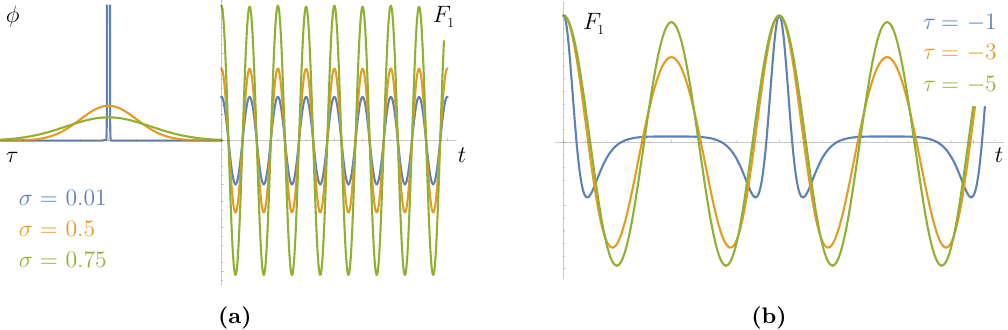
Figure 4. F 1 ( t ) for localized sources. (a) Gaussian sources on the Euclidean section with varying widths σ for a sample value of τ . The limit σ → 0 for which the source becomes a Dirac delta gives a finite response. Although drawn horizontally, the negative horizontal axis corresponds to imaginary time τ . (b) Sample responses for Dirac delta sources at different Euclidean locations τ < 0 . In the τ → −∞ limit, the response reduces to the (fundamental) frequency ω = ∆ . This is consistent with the fact that the insertion of a source at τ = −∞ corresponds to a particle state in its fundamental state ω = ∆ , i.e. at rest in the center of 00